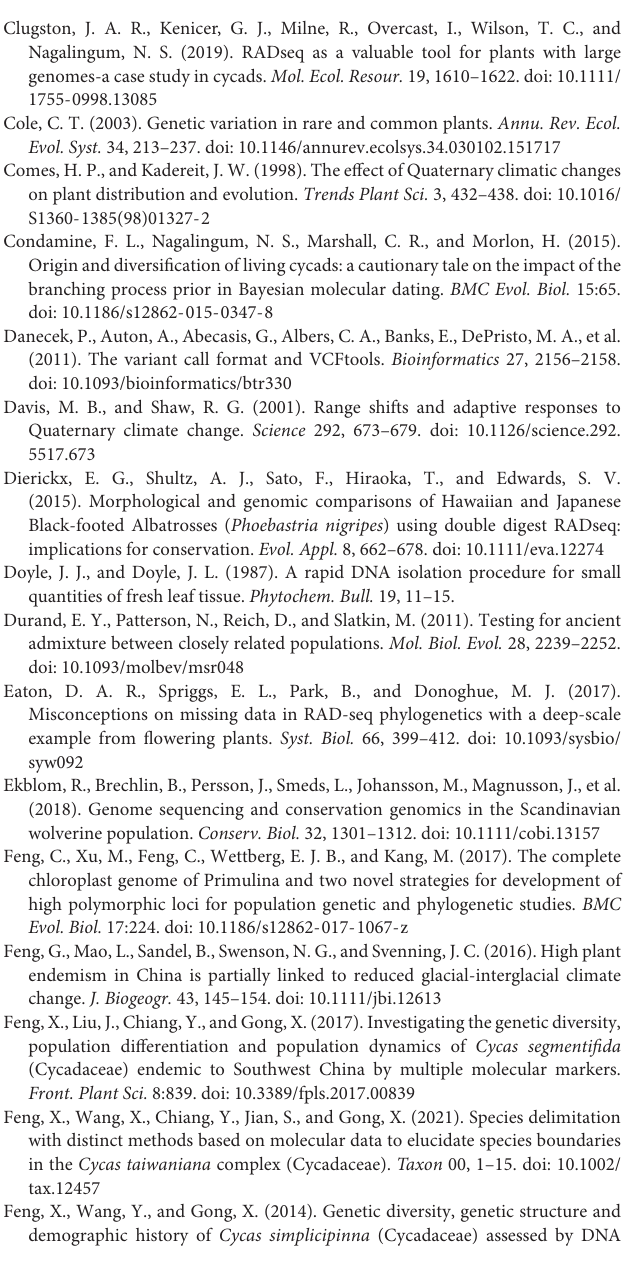
Supplementary Figure 1 | PCA results for different parameter sets during preliminary analysis. Supplementary Figure 2 | Characteristics of SNPs for the Dataset 1 used in the present study. (A) Distribution of mean coverage per locus across 152 individuals for the genomic SNP of the six Cycas species; (B) Distribution of the number of loci per individual for the genomic SNP of the six Cycas species.